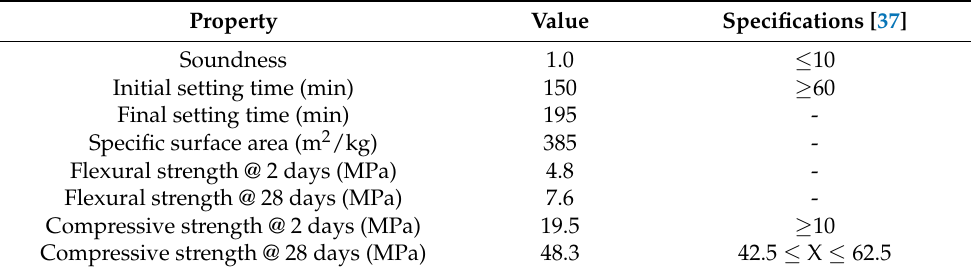
Table 1. The physical and mechanical properties of cement.